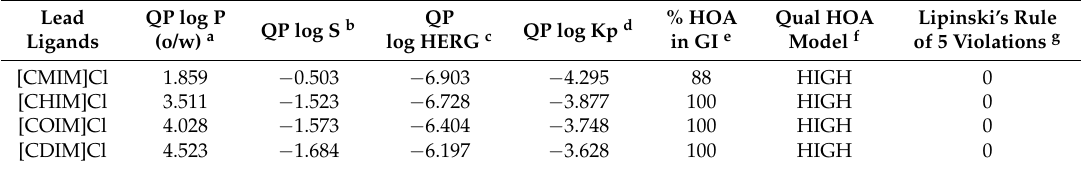
Table 5. Pharmacokinetics properties predicted by QikProp